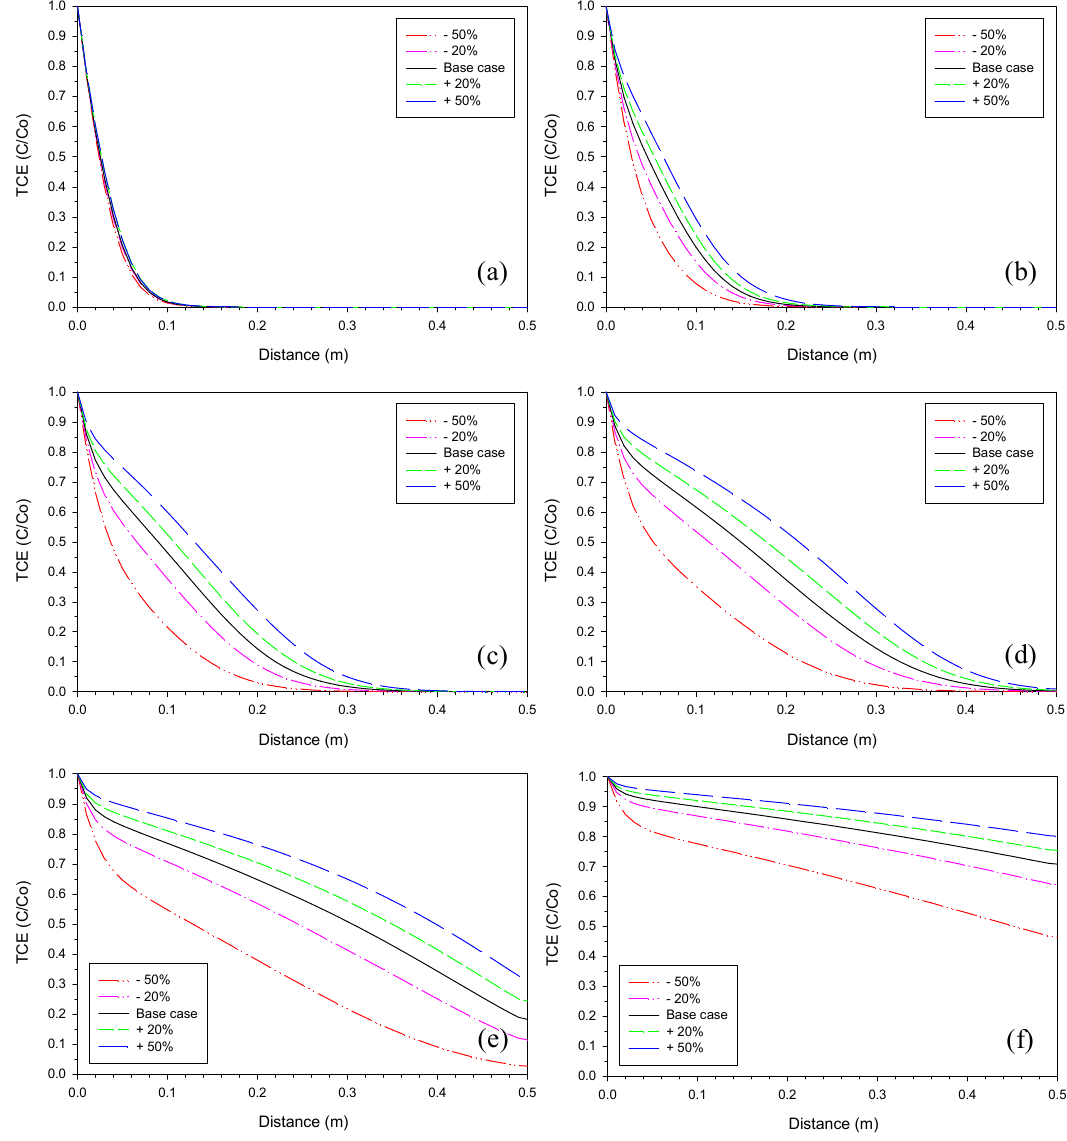
Figure 1. Sensitivity analysis of iron corrosion rate. TCE profiles on ( a ) Day 4, ( b ) Day 25, ( c ) Day 54, ( d ) Day 87, ( e ) Day 164, and ( f ) Day 410 with value of the base case, +/−20% and +/−50%.